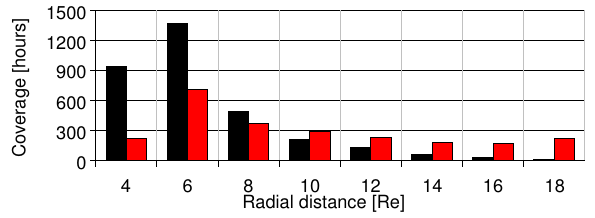
Fig. 1. Distribution of the EDI measurements versus geocentric radial distance. Black colors indicate northern hemisphere, red colors southern hemisphere. The majority of the EDI measurements in the Northern Hemisphere are taken at radial distances below 10 R E , whereas the Southern Hemisphere data set contains more measurements from distances beyond 10 R E .